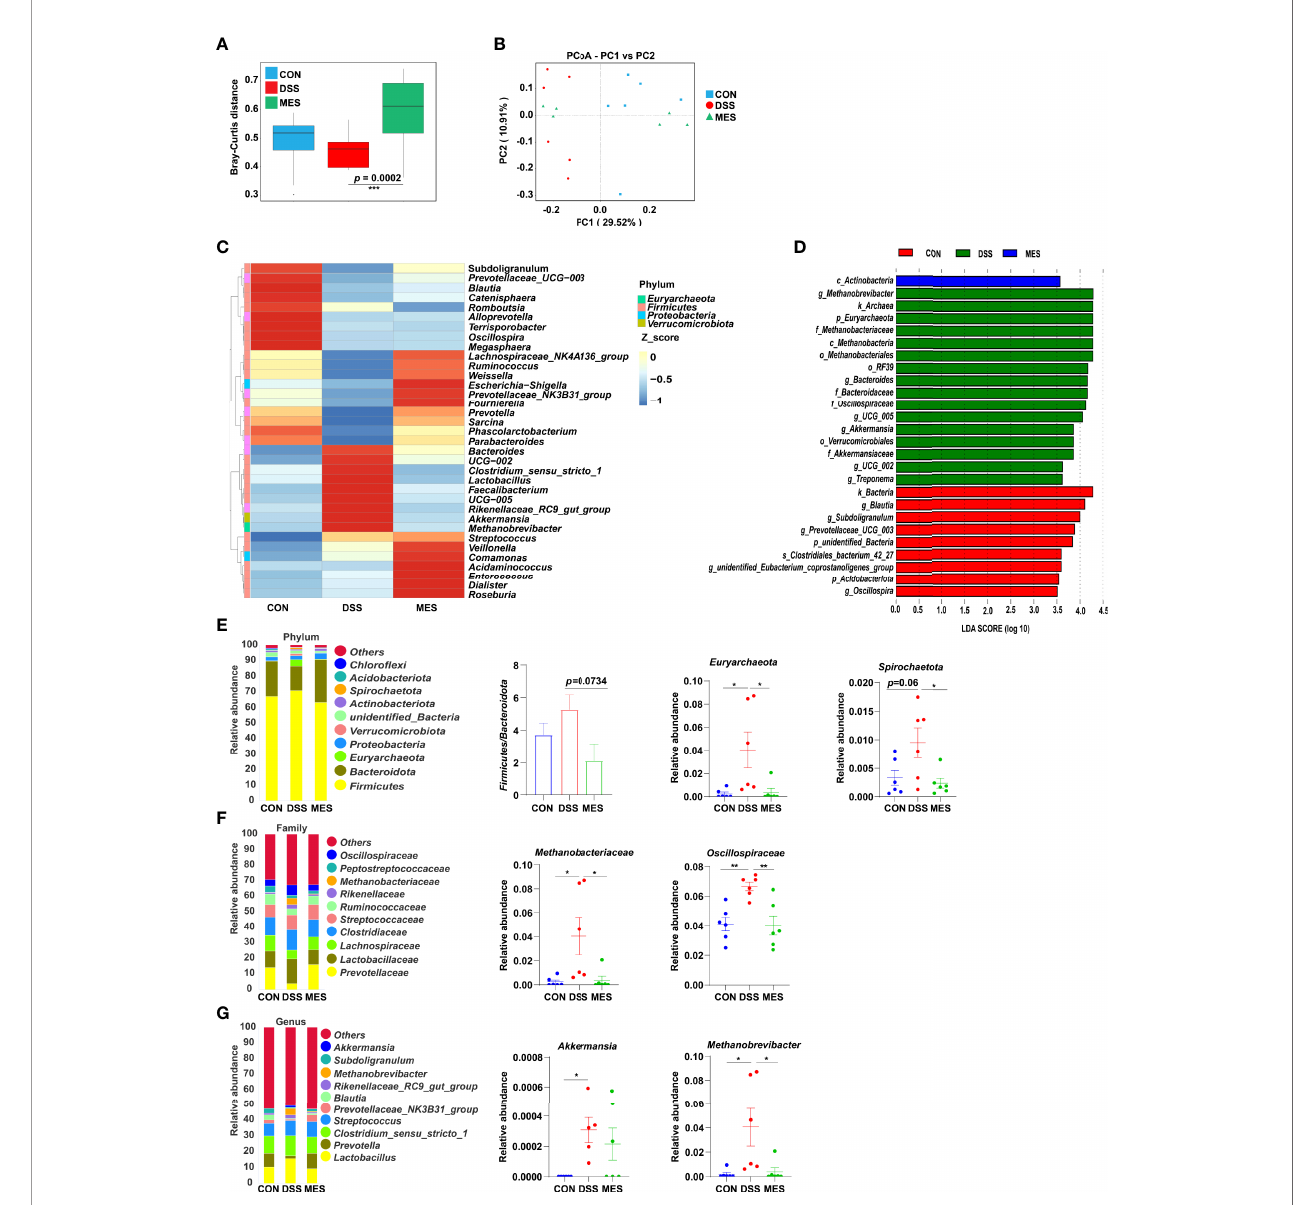
FIGURE 4 | MES modulates gut microbiota in piglets with DSS-induced colitis. (A) Rank abundance curves of beta diversity in the CON, DSS, and MES groups; (B) PCoA plots upon MES therapy assessed by PERMANOVA; (C) heatmaps of species abundance at the genus level; (D) LEFSe analysis revealed the dominant bacteria in the CON, DSS, and MES groups; relative abundance of top 10 (E) phyla, (F) families, (G) genera in the CON, DSS, and MES groups. * P < 0.05, ** P < 0.01, *** P <